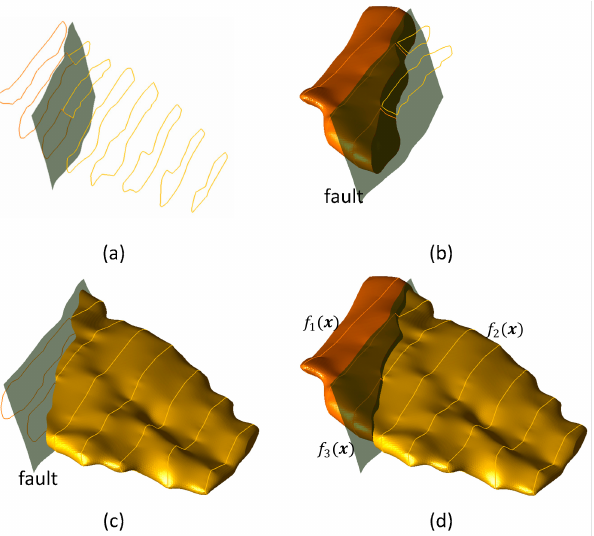
Figure 5. Combination constraint of the discontinuous mineralization space with a fault: ( a ) the fault surface and interpreted contours; ( b ) the combined hanging wall orebody; ( c ) the combined foot wall orebody; ( d ) the combined